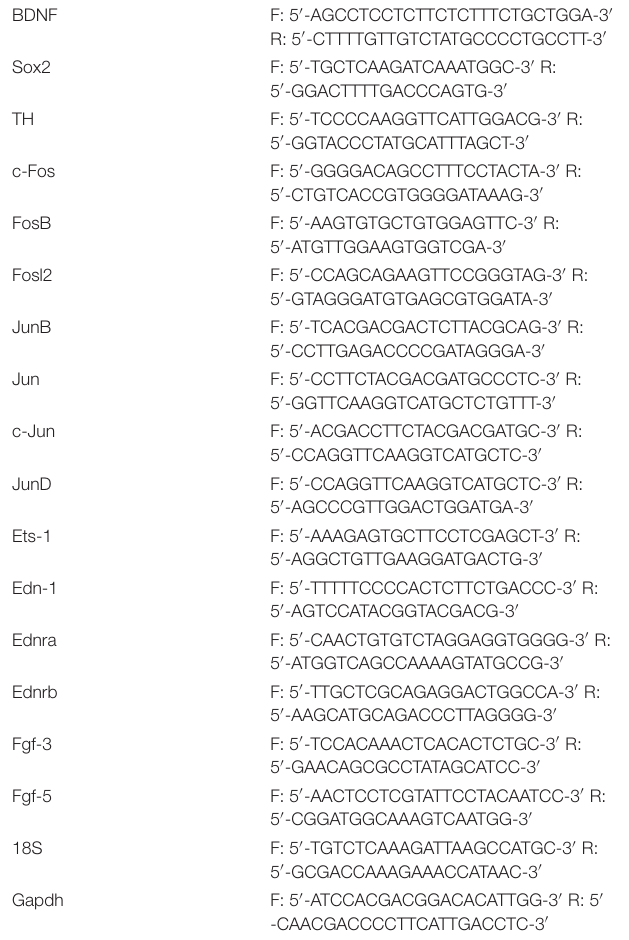
TABLE 1 | List of qPCR primers used for validation of differential gene